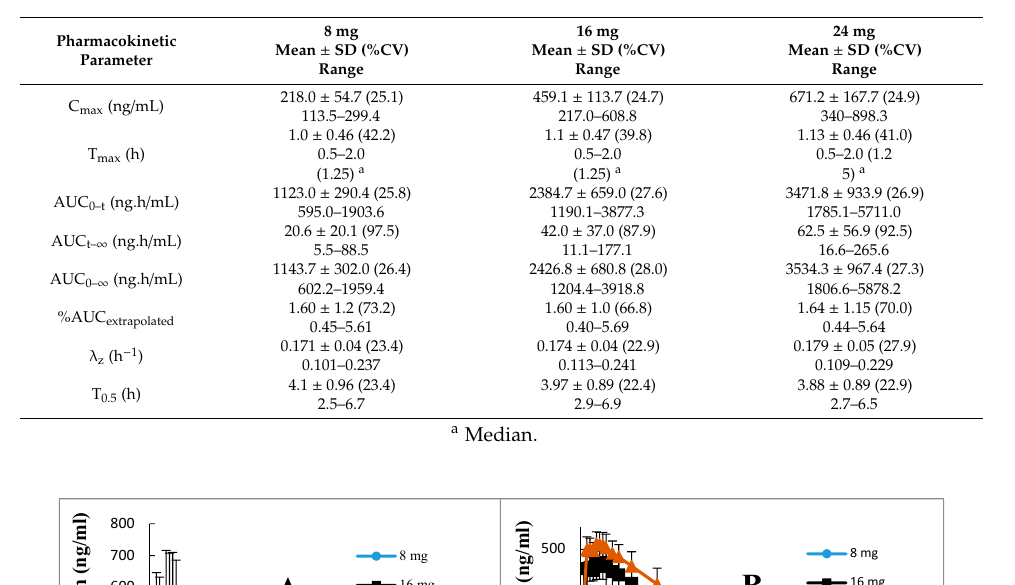
Table 2. Pharmacokinetic parameters of 2-pyridyl acetic acid in 36 healthy, fasting adult male subjects after administration of single doses of 8, 16 and 24 mg betahistine dihydrochloride.